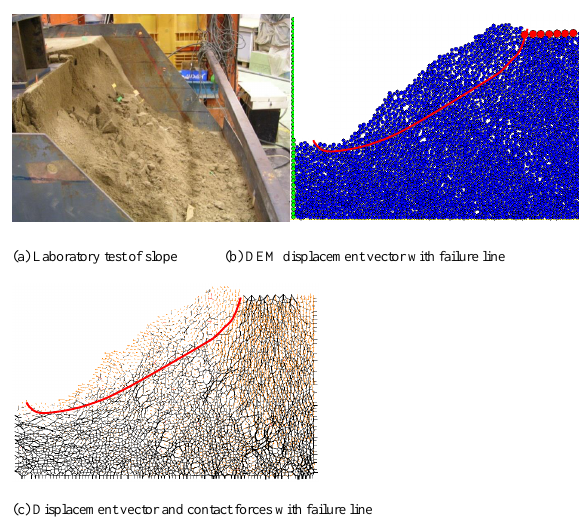
Figure 15 Side view for the final failure from laboratory test and DEM modelling Figure 15. Side view for the final failure from the laboratory test